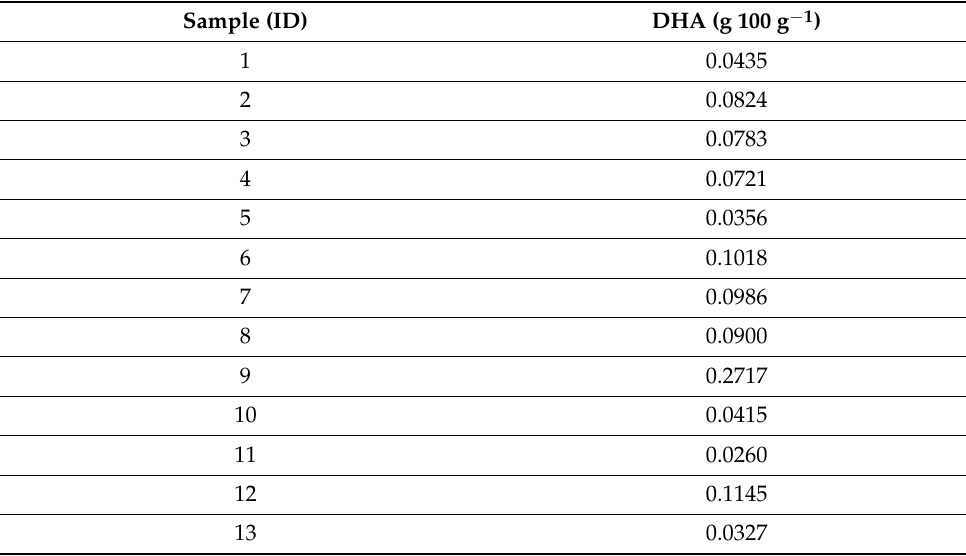
Table 3. Docosahexaenoic acid (DHA) values milk from nursing mothers living in the city of